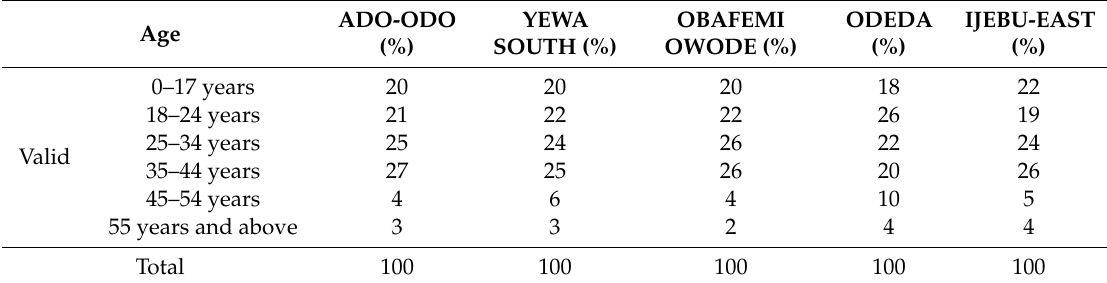
Table 2. Age distribution of the respondents.